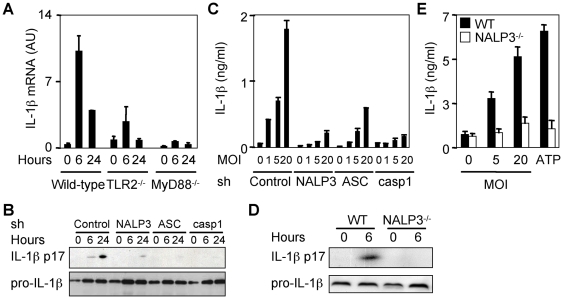
Crosstalk between TLR2-MyD88 and the NALP3 inflammasome for IL-1β expression and processing.(A) Wild-type, TLR2−/− and MyD88−/− BMDMs were primed overnight with ultra-pure LPS (100 ng/ml) and infected with MVA (MOI 5). IL-1β mRNA expression was quantified by RT-PCR (p<0.05 for TLR2−/− or MyD88−/−
vs. wild-type BMDMs). THP-1 cells stably transduced with control, NALP3, ASC and caspase 1 (casp1) shRNAs were infected with MVA (MOI 5 unless specified otherwise) for the indicated time (B–C). (B) Western blots of intracellular pro-IL-1β and secreted IL-1β p17. (C) IL-1β concentrations measured by ELISA in cell-culture supernatants collected 24 h after infection (p<0.05 for cells transduced with NALP3, ASC and casp1 shRNAs vs. control shRNA). LPS-primed wild-type and NALP3−/− BMDMs were infected with MVA (MOI 5 in D) for 6 h (D–E). (D) Western blots of intracellular pro-IL-1β and secreted IL-1β p17. (E) IL-1β concentrations measured by ELISA in cell-culture supernatants collected 24 h after infection. Results are expressed as the ratio of IL-1β mRNA levels to that of HPRT. Data are means±SD of triplicate samples from one experiment and are representative of two independent experiments (p<0.05 for NALP3−/−
vs. wild-type BMDMs).